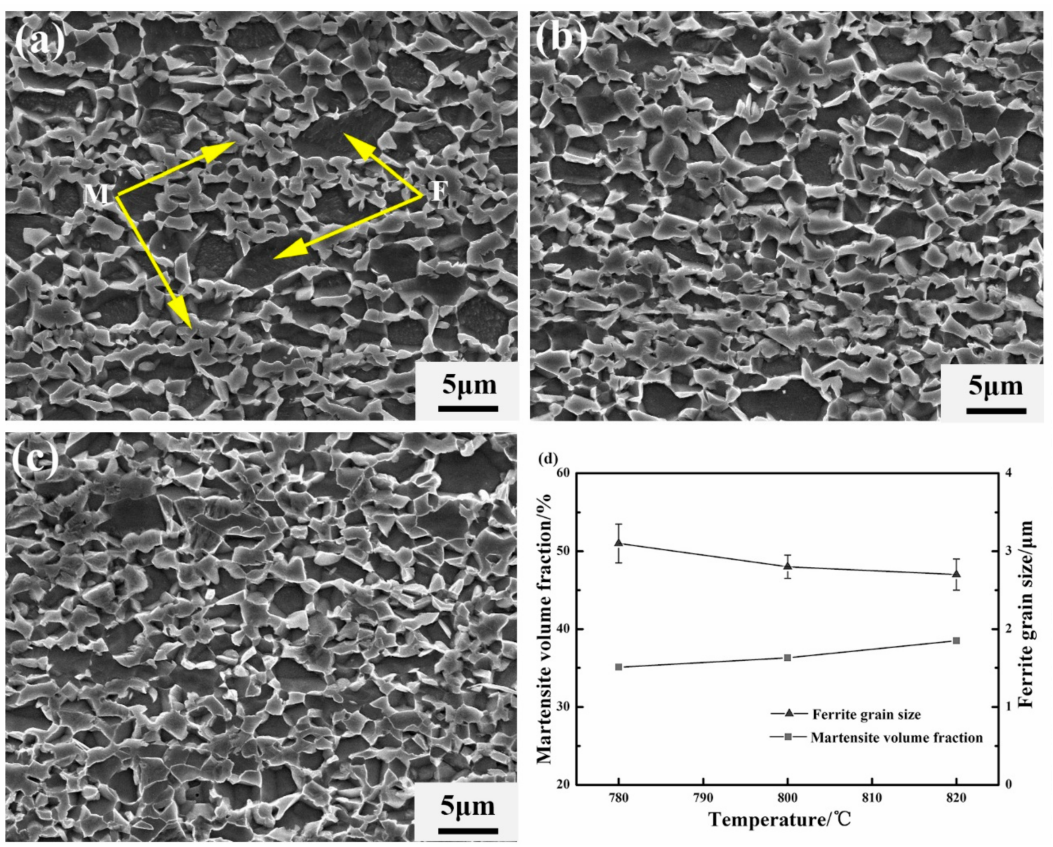
Figure 4. SEM micrographs of deformed ferrite–martensite after annealing for 1.5 min at ( a ) 780 ◦ C; ( b ) 800 ◦ C; ( c ) 820 ◦ C; and ( d ) martensite volume fraction and ferrite grain